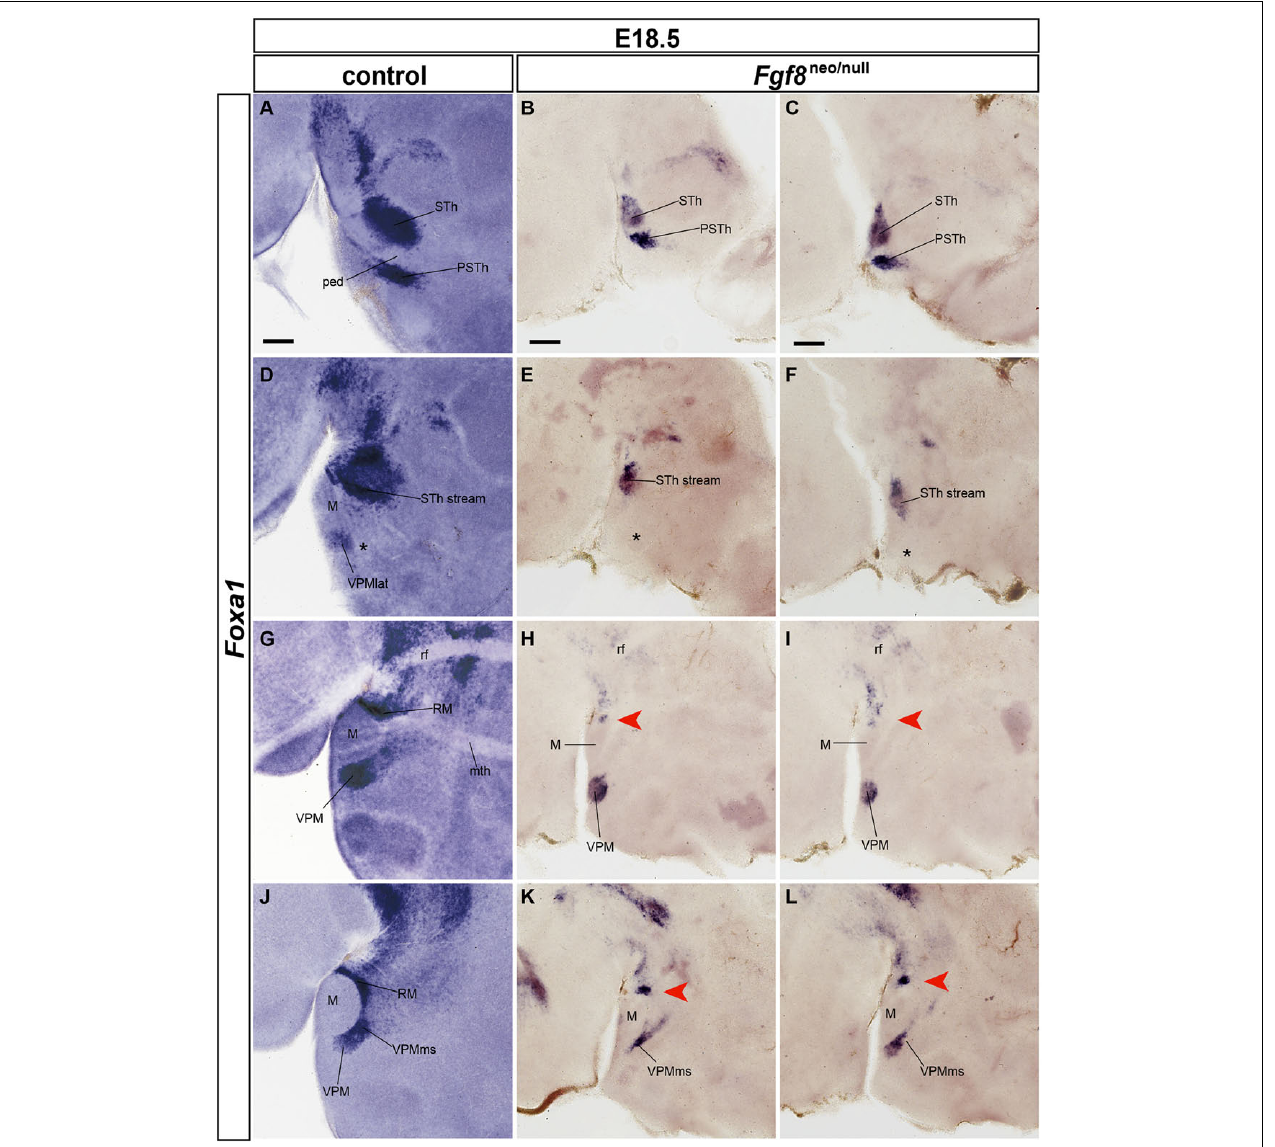
FIGURE 14 | Severe Fgf8 neo / null hypomorphs display RM, VPMms, VPM and STh atrophy at E18.5. (A,D,G,J) Latero-medially ordered sagittal sections of a wildtype E18.5 embryo labeled with Foxa1 ISH to show RM, STh and VPM cell populations. (B,E,H,K) Right side latero-medial sagittal sections of an E18.5 Fgf8 neo / null specimen reacted for Foxa1 ISH. (C,F,I,L) Equivalent left-side sections of the same E18.5 Fgf8 neo / null specimen. There is a general reduction in size of the mutant compared with the wildtype specimen (note the magnification is the same in both cases). The migrated STh and VPM show a reduced size, though the respective migrations out of RM have occurred. Red arrowheads in (E,F) suggest lack of lateralmost VPM cells at levels through the STh nucleus, and red arrowheads in (H,I,K,L) suggest a significant reduction in the cellularity of the RM area. Scale bars represent 200 µ